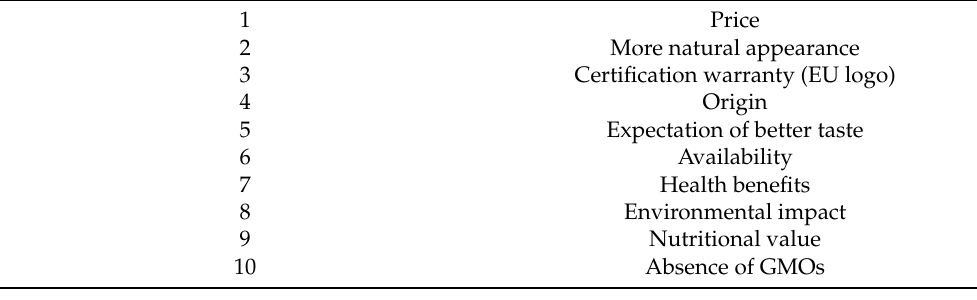
Table 1. Organic attributes.